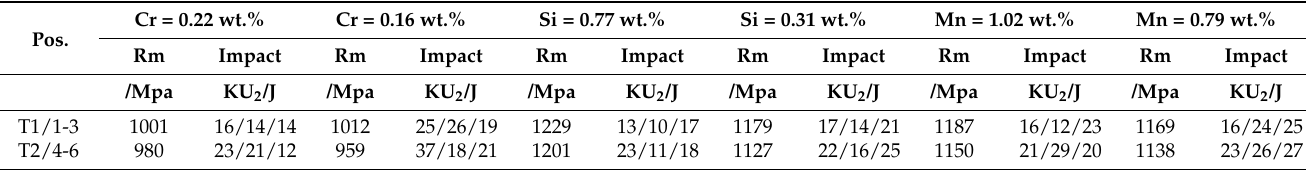
Table 2. The test results of different Cr/Si/Mn content.